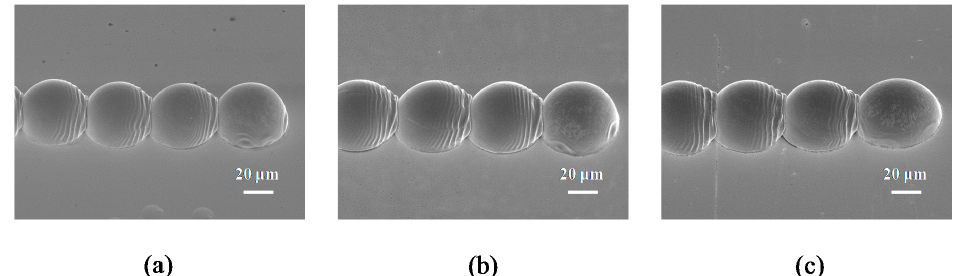
Figure 8. The deposition of a molten metal droplet under different stage temperatures with the following initial characteristics: diameter D 0 = 50 μ m, velocity = 1.1 m ∙ s − 1 , dot spacing = 50 μ m, and motion velocity = 50 mm ∙ s − 1 (frequency = 1000 Hz). ( a ) 30 °C (Ste = 0.722); ( b ) 50 °C (Ste = 0.645); ( c ) 70 °C (Ste = 0.567). The scale bars are 20 μ m.